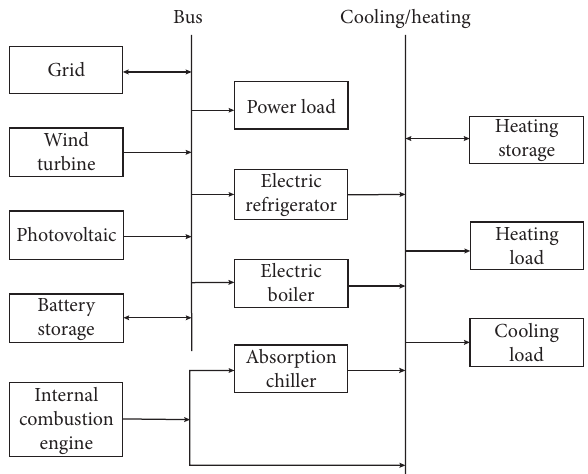
Figure 1: Multienergy complementary system